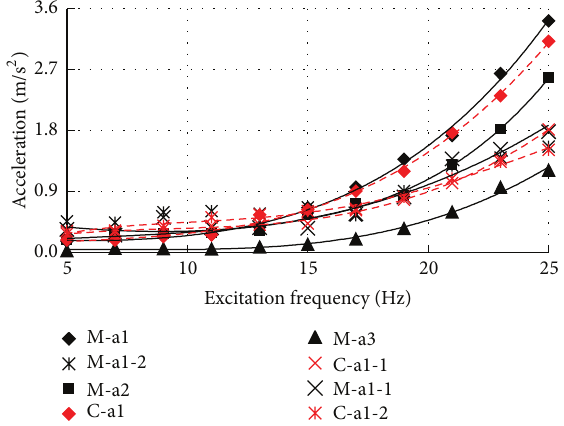
Figure 10: Vertical acceleration on the soil versus vibration exciter input